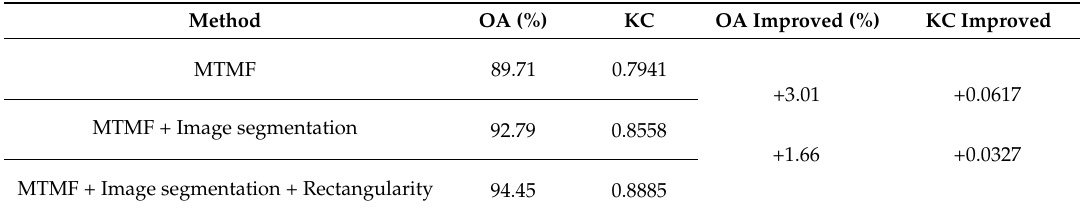
Table 5. ISA extraction accuracy comparisons of the three gradually extended integrations of the methods that were adopted for the DMBLC method. MTMF: mixture tuned matched